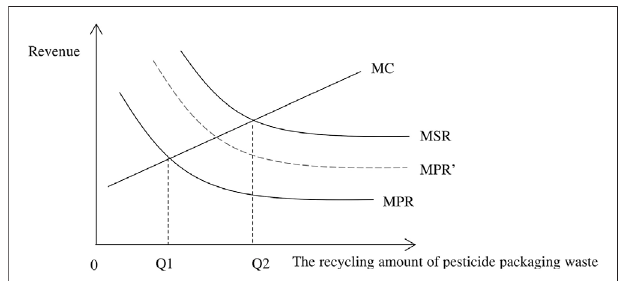
FIGURE 1 | In fl uence of the punish policy on the recycling level of pesticide packaging